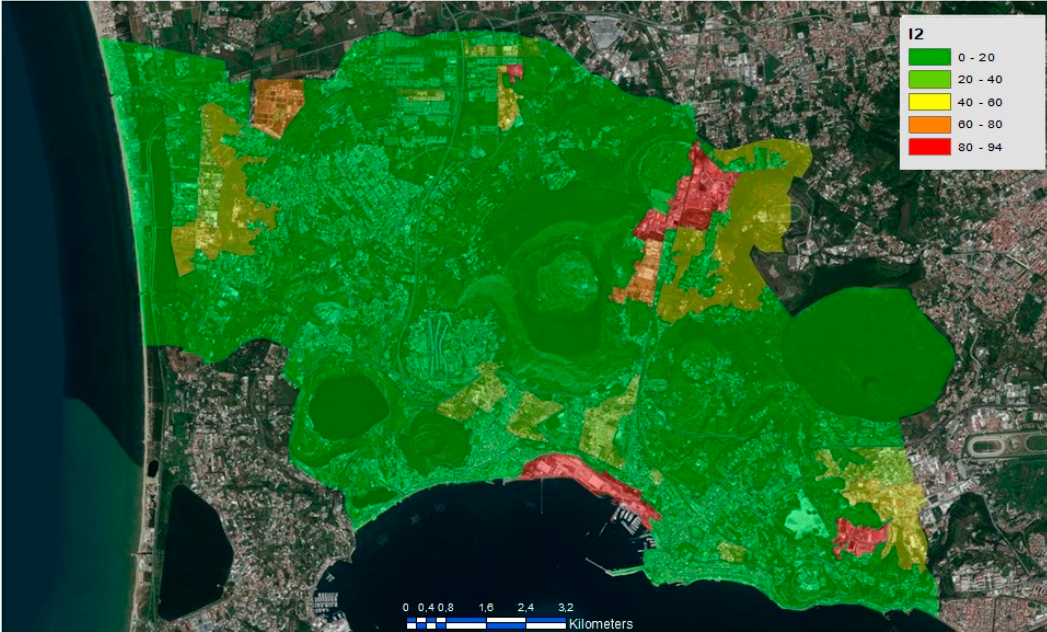
Figure 7. Thematic map of the indicator I 2 —Percent of industrial areas with respect to total built areas.